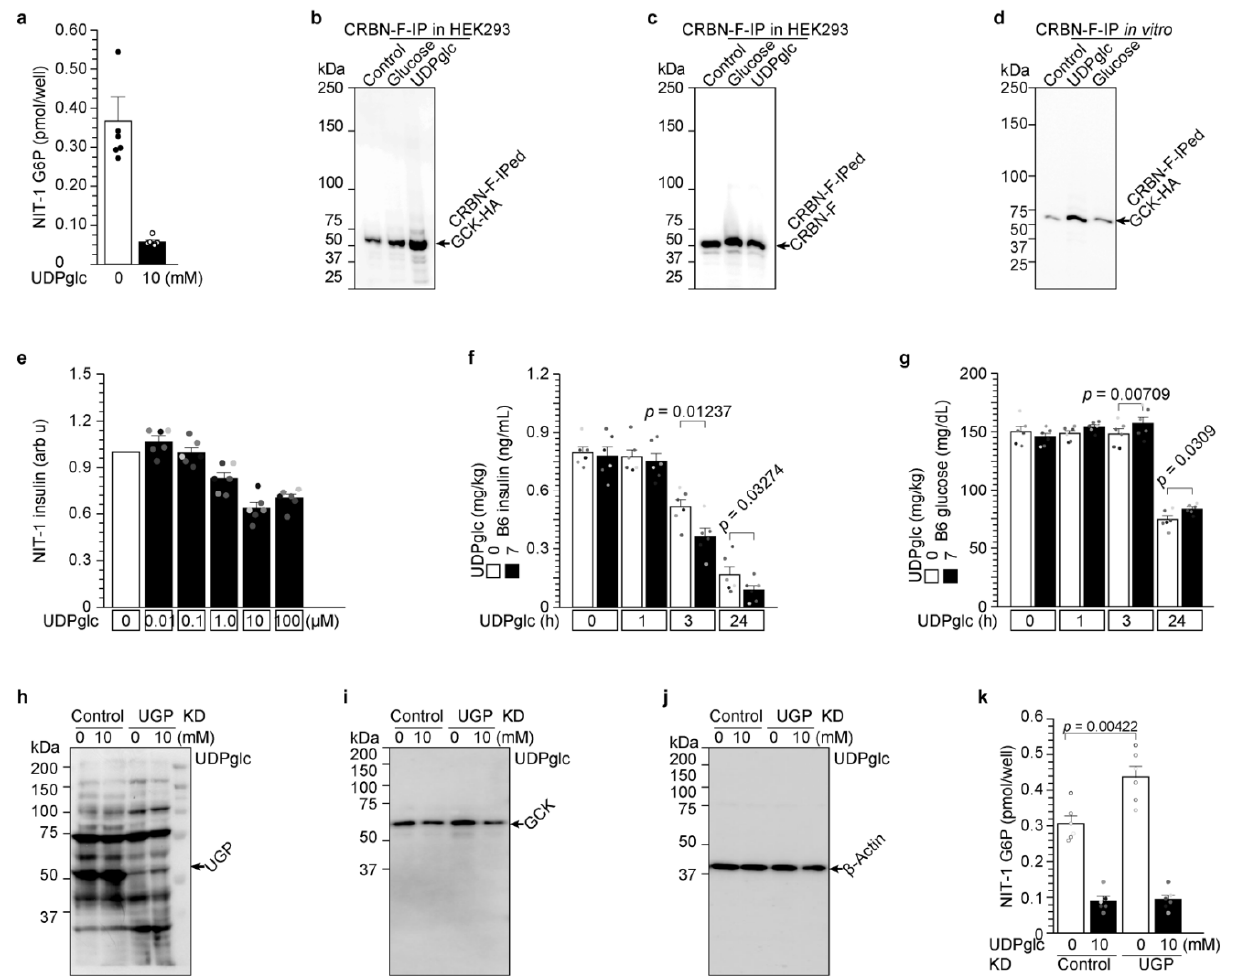
insulin secretion in NIT-1 cells (Figure 4e) and mice (Figure 4f). In addition, UDP-glucose induced glucose concentration due to reduced insulin secretion (Figure 4g).